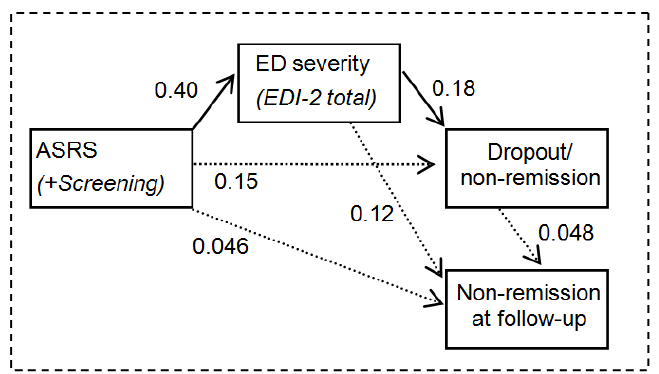
Figure 4. Path-diagrams: standardized coe ffi cients in the SEM for the follow-up ( n = 123). Continuous line: significant coe ffi cient. Dash line: non-significant coe ffi cient. Results adjusted by age and duration of the